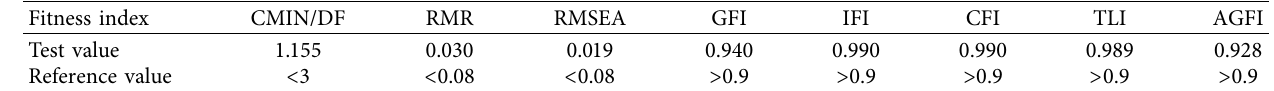
Table 7: Fitness index values of our conceptual